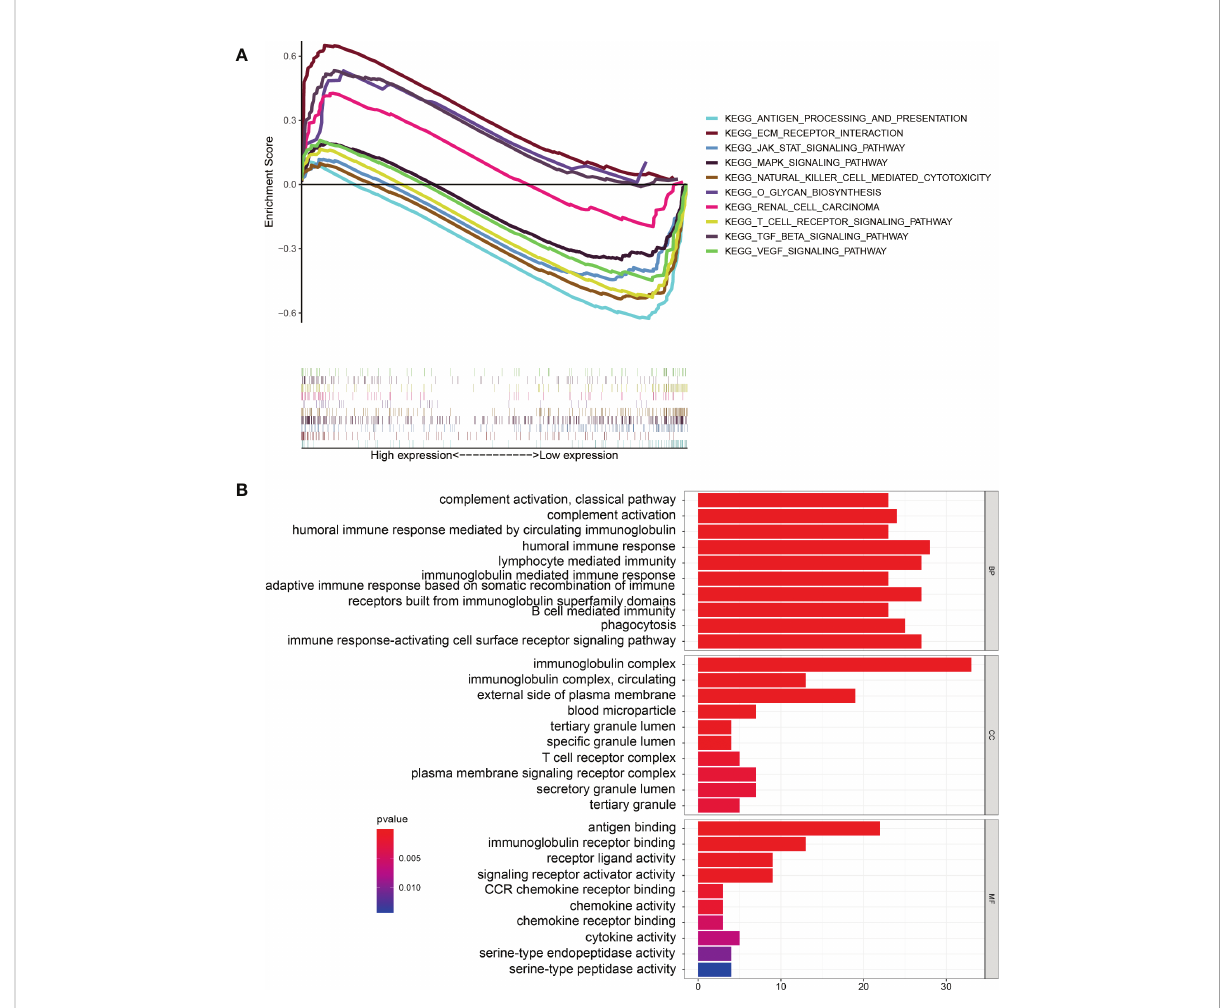
FIGURE 6 Gene Set Enrichment Analysis. (A) KEGG pathway enrichment analysis indicating that several immune-related pathways were enriched in the low-risk group. (B) GO enrichment analysis suggesting that several immune-related functions were enriched in the different